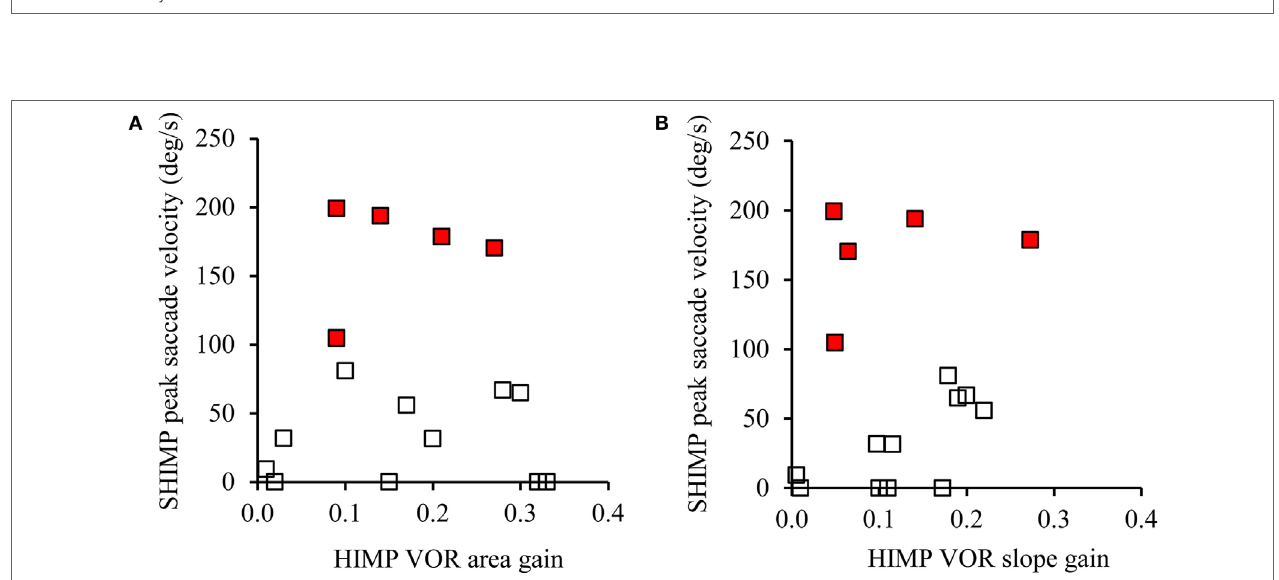
FigUre 4 | The relation between vestibulo-ocular reflex (VOR) gain and average peak anti-compensatory eye velocity (°/s) in the SHIMPs paradigm as a function of VOR area gain (a) and VOR slope gain (B) in eight bilateral vestibular loss (BVL) patients (left and right sides). Some patients had low head impulse test (HIMP) gain/HIMP slope and low peak saccade velocity (open squares): these patients performed small or no anti-compensatory saccades in SHIMPs. On the other hand, other BVL patients (red squares) showed low VOR gain by either measure, but had large anti-compensatory saccades in SHIMPs because of earlier covert saccades.